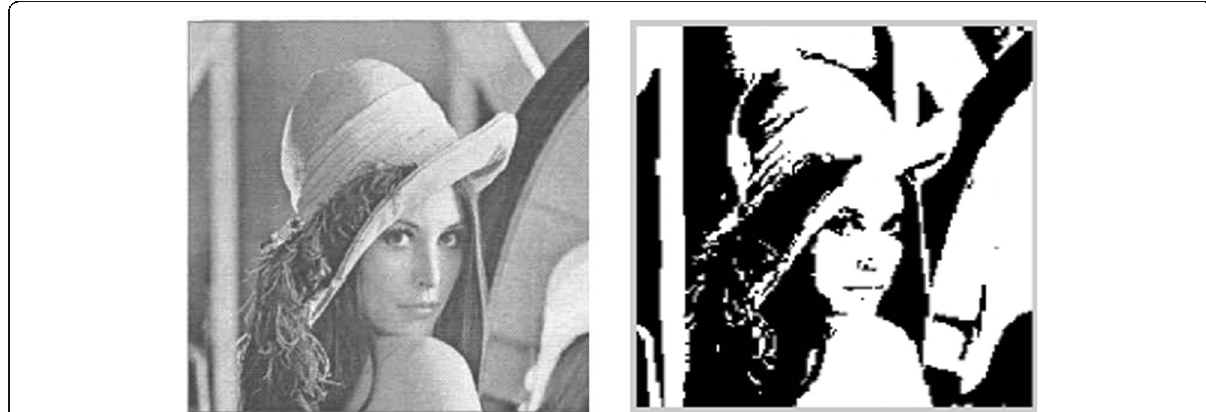
Fig. 3 Image contrast effect before and after iterative segmentation (threshold Th =